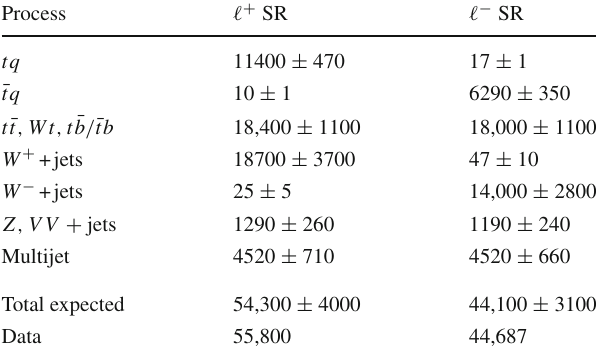
Table 1 Predicted and observed event yields for the signal region (SR). The multijet background prediction is obtained from a binned maximum-likelihood fit to the E miss distribution. All the other predic- T tions are derived using theoretical cross-sections, given for the back- grounds in Sect. 6 and for the signal in Sect. 1. The quoted uncertainties are in the predicted cross-sections or in the number of multijet